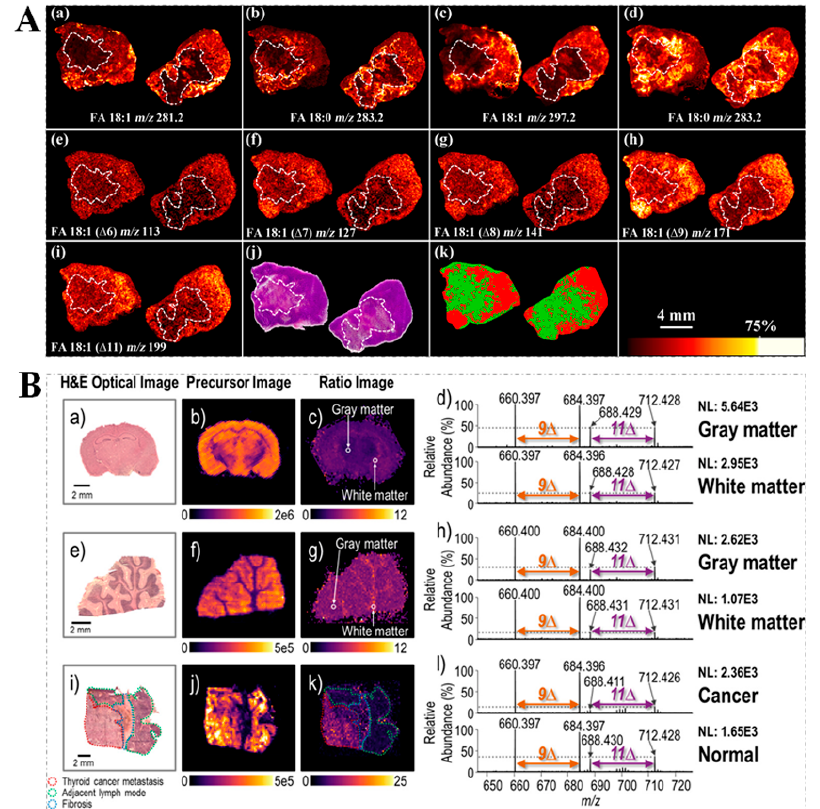
Figure 8. ( A ) The on-tissue PAA epoxidation strategy combined with MALDI-TOF/TOF-MS platform to map the spatial distribution of FA isomers in tissue sections. Full-MS images of ( a ) FA 18:1 and ( b ) FA 18:0 without epoxidation as well as ( c ) epoxy-FA 18:1 and ( d ) FA 18:0 after on-tissue epoxidation. MALDI-TOF/TOF-tandem MS images of ( e ) FA 18:1 (D6), ( f) FA 18:1 (D7), ( g ) FA 18:1 (D8), ( h ) FA 18:1 (D9), ( i ) FA 18:1 (D11). ( j ) The H&E stained histological image. ( k ) Segmentation pipeline analysis of the MS 2 data: region rich in cancer cells (red) and region containing few cancer cells with necrosis (green). The left side tissue section was from untreated sample while the right side tissue section was from sample treated with radiation in all the images. (reproduced from Ref. [5] with permission from the Royal Society of Chemistry); ( B ) DESI − MS coupled with the 193 nm UVPD for characterization of phospholipid isomers in tissue sections. H&E optical images of different tissue sections, including ( a ) mouse brain, ( e ) human brain, and ( i ) lymph node with thyroid cancer metastasis. DESI-MS ion image of m / z 798 in different tissue sections, including ( b ) mouse brain, ( f ) human brain, and ( j ) lymph node with thyroid cancer metastasis. ( c ) DESI- UVPD ratio image of the ratio of the summed intensities of the UVPD double-bond diagnostic ions (I m / z 660 + 684 )/(I m / z 688 + 712 ), ( g ) DESI ratio image of the ratio of the summed intensities of the UVPD double-bond diagnostic ions (I m / z 660 + 684 )/(I m / z 688 + 712 ), and ( k ) DESI intensity ratio image of (I m / z 684 /I m / z 712 ). Expanded region of UVPD mass spectra of ( d ) the white and gray matter, ( h ) the white and gray matter, and ( l ) cancerous and normal parts of tissue. (reproduced permission from Ref. [87]. Copyright (2018) American Chemical